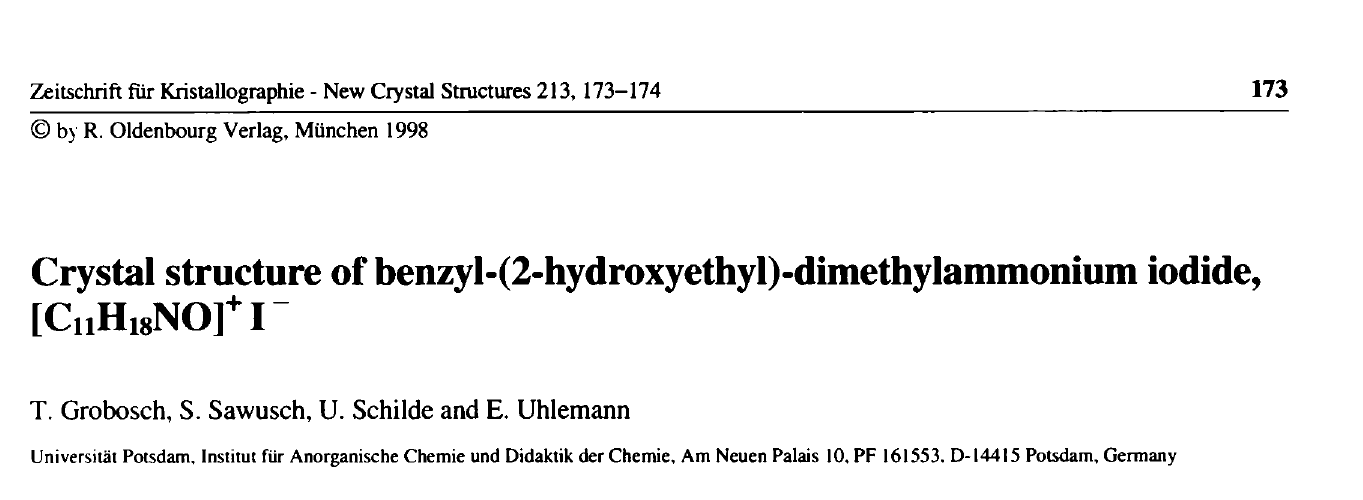
Table 1. Parameters used for the X-ray data collection Crystal: